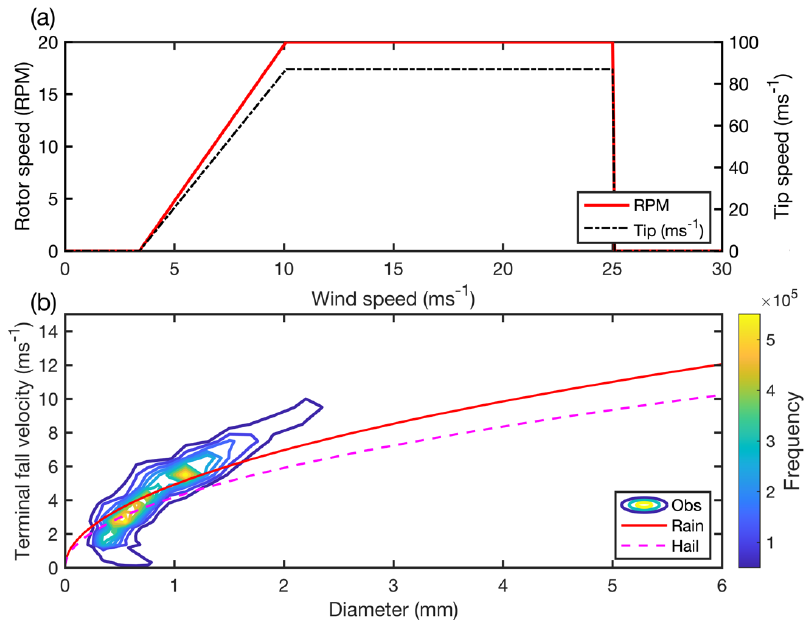
Figure 1. ( a ) Simplified wind turbine rotor speed (revolutions per minute, RPM) and tip speed (ms −1 ) as a function of hub-height wind speed for a typical wind turbine with a rated capacity of 1.5–2 MW (e.g., GE 1.5 SLE). Estimation of the tip speed from the blade RPM assumes a blade diameter of 83 m. Power production begins at 3.5 ms − 1 and ceases at hub-height wind speeds >25 ms − 1 , thus no RPM or tip-speed data are plotted for wind speeds outside of this range. ( b ) Contours of the joint probabilities of terminal fall velocities ( v t ) and hydrometeor diameter ( D ) based on 4 years of optical disdrometer data (2017–2020) from the US Department of Energy (DoE) Atmospheric Radiation Measurements (ARM) site at Lamont in the US Southern Great Plains (US SGP). Additionally, shown are v t estimates as a function of D computed for rain droplets and hail using Equations (1) and (3) (lines) and the following assumptions: ρ o = 1.225 kgm − 3 , ρ air = 0.999 ρ o , ρ i = 900 kgm − 3 . A range of approximations have been proposed to describe the dependence of hy- drometeor v t on their diameter ( D ), phase, morphology and density [39]. Estimates shown in Figure 1b are computed using: where R = droplet radius (m), κ = 220 m 1/2 s − 1 , ρ o = air density at sea level (kgm − 3 ), ρ air = air density at the altitude above sea level (kgm − 3 ) [40]. Early research [41] suggested that droplet v t should be calculated within three different diameter ranges. The following is valid for droplet diameters ( D ) > 0.05 mm (5 × 10 − 5 m);